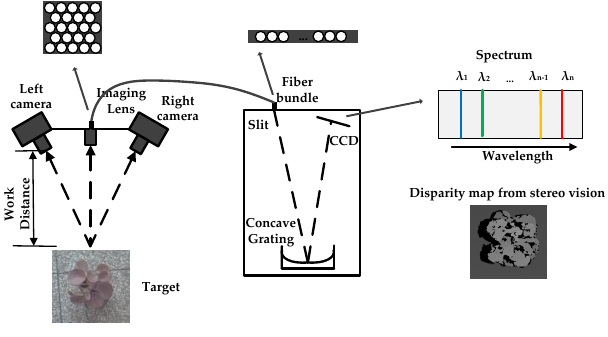
Figure 3. Schematic of the integrated